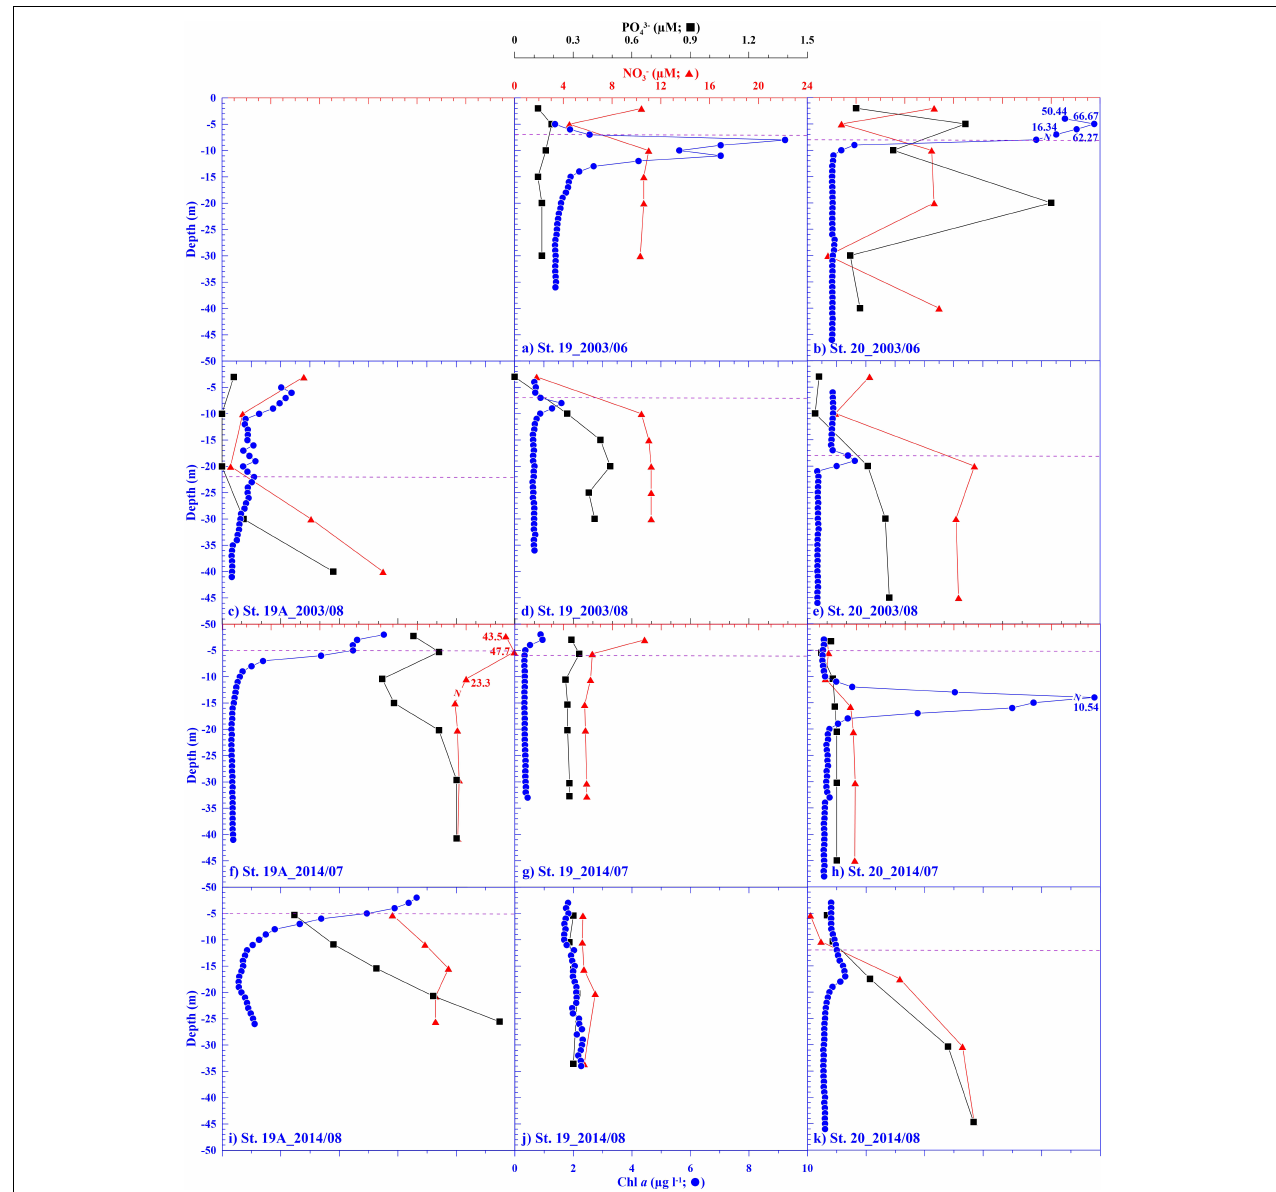
FIGURE 5 | Depth profiles of nitrate ( (cid:78) ), phosphate ( (cid:4) ), and chlorophyll a (Chl a ; (cid:108) ) at St. 19A, 19, and 20 in different sampling periods in East China Sea. Please refer to Figure 1 for stations. For reference, the horizontal dashed lines indicate the mixed layer depth at stations. Please note that panels (a–e) were modified from Chen et al.